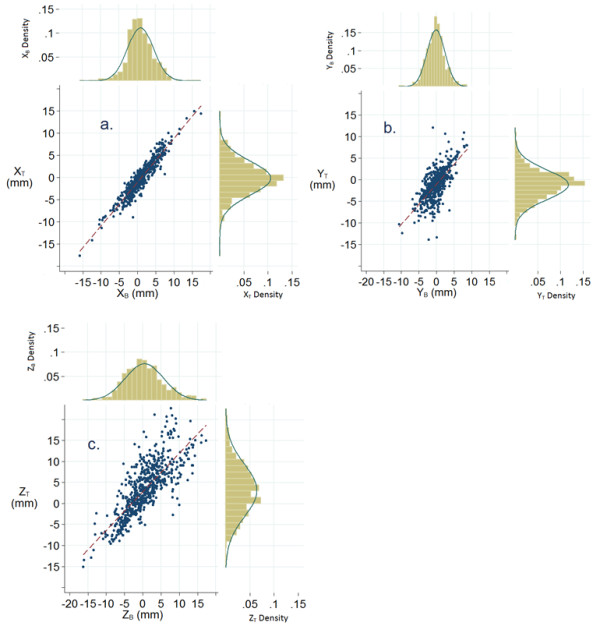
Histograms of the shifts along × (LR), Y (SI), Z (AP) for the two matching modalities and corresponding scatterplots. Distributions of the shifts (in mm) along left-right (X) (a), supero-inferior (Y) (b), and antero-posterior (Z) (c) axes for the two matching modalities (B-match and T-match), along with the scatterplots of the corresponding shifts. Bell curves are computed using mean and standard deviation of the underlining variables. Dashed lines represent the bisectors. The scatterplots shown in Figure 1a (XT vs XB), Figure 1b (YT vs YB), and Figure 1c (ZT vs ZB), have correlation coefficients of 0.94, 0.74 and 0.78, respectively, all highly statistically significant (p-value < 0.001). Note that ZT tends to be larger than ZB, especially for larger values of ZB (Figure 1c).